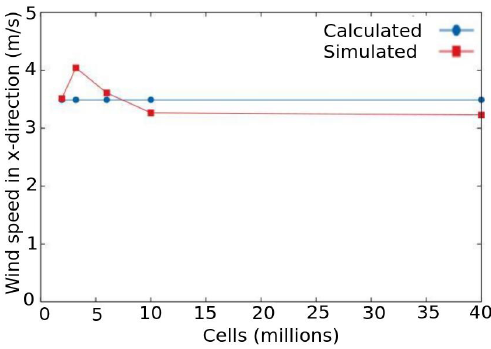
Figure 7. Grid independence test and